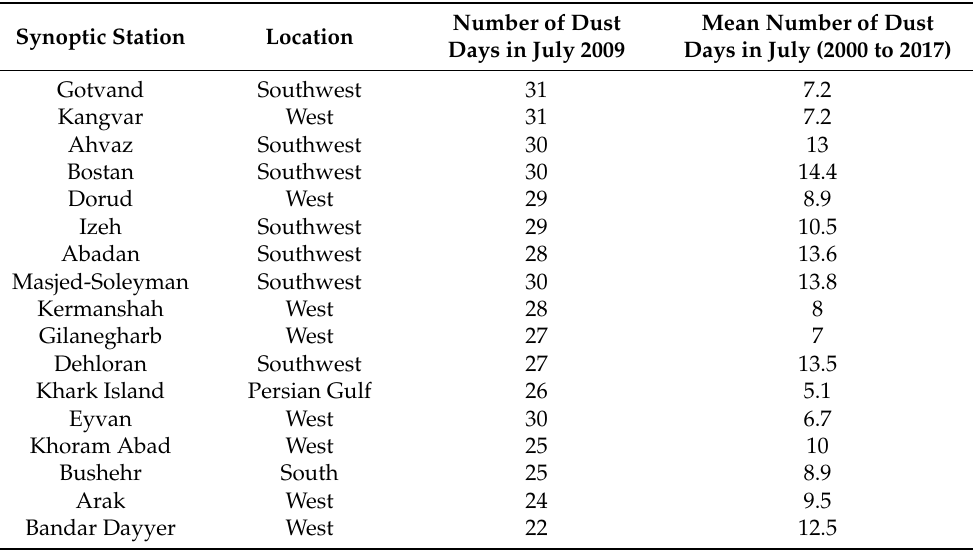
Figure 3. ( a ) Inter-annual variation of common dust days in all of 5 stations in SW Iran, ( b ) the ratio of common dust days in all of 5 stations per the number of dust days in each station, ( c ) mean monthly dust days per station, ( d ) monthly frequency of dust days in each station during the period 1997–2018. Table 2. Number of dust days in July 2009 with respect to the average number of dust days during July months of the period 2000–2017 at meteorological stations in west, southwest, and south